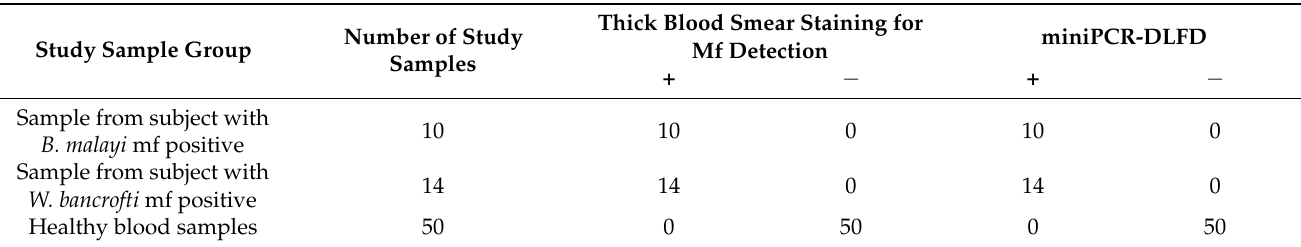
Table 2. Comparison of the miniPCR-DLFD based amplification and microfilariae detection by stained thick blood smear for diagnosis of infection with W. bancrofti and B. malayi in the study blood